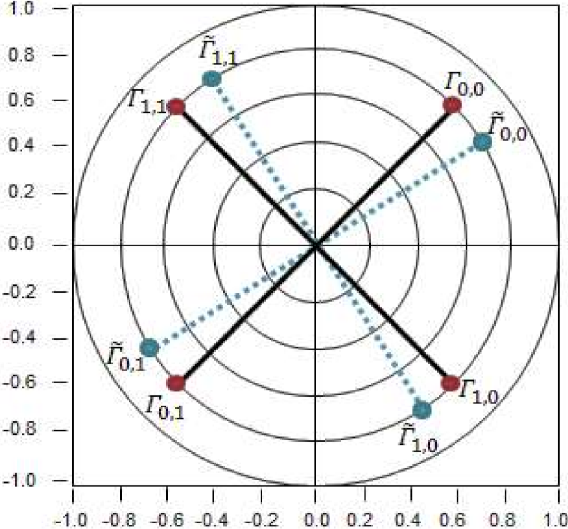
Figure 6. Backscatter constellation.